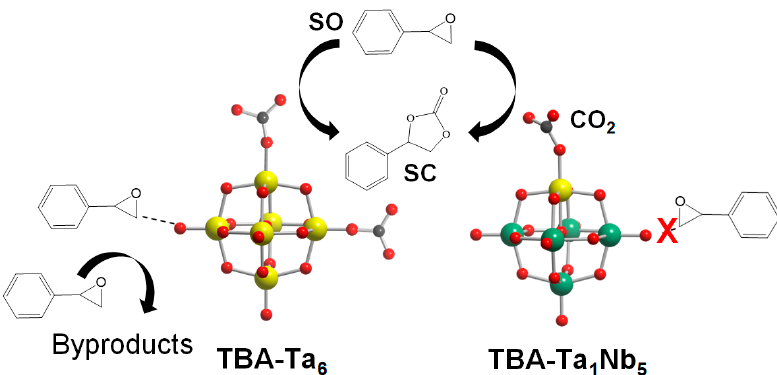
8 of 11 Figure 7. Total energy of CO 2 -adsorbed [Ta 1 Nb 5 O 19 ] 8 − at different base sites. The reaction mechanism of TBA-Ta x Nb 6 − x for CO 2 fixation to SO is discussed. In the case of TBA-Nb 6 , CO 2 is adsorbed on the terminal O Nb sites and the activated CO 2 reacts nucleophilically with SO to form SC . The low catalytic activity of TBA-Nb